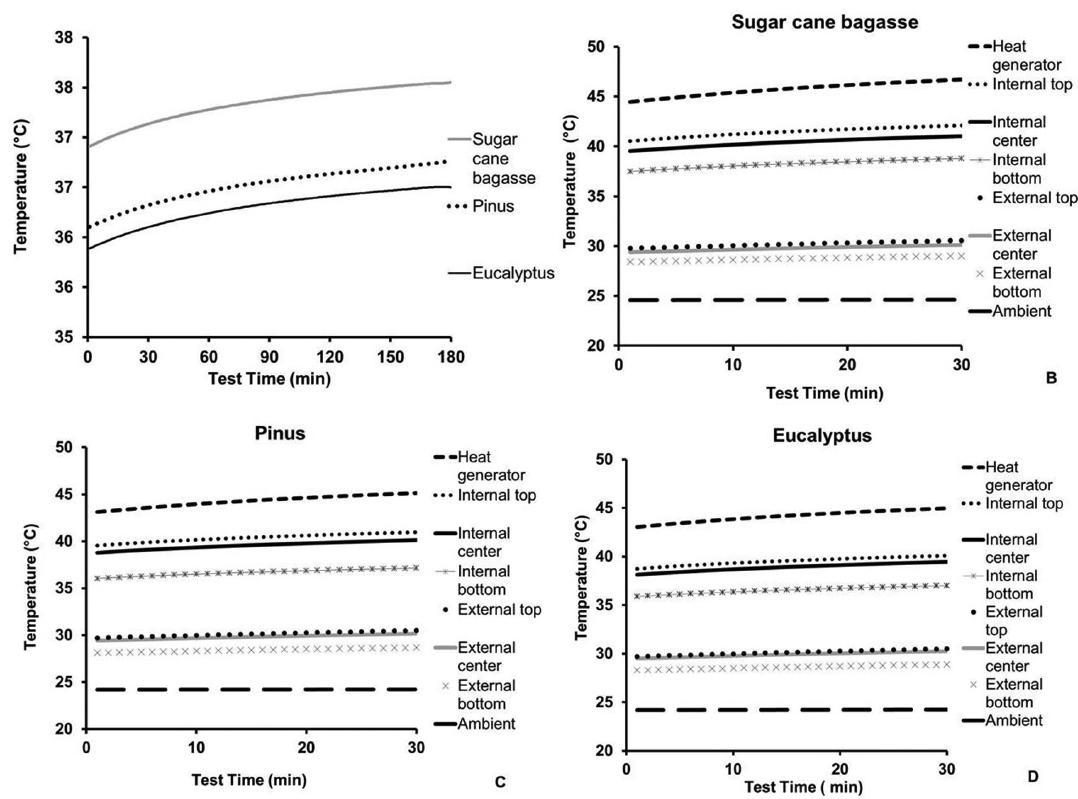
Figure 2. (A) behavior of the temperature throughout the test time for the three types of panel, behavior of the temperature in the first 30 minutes for the panel made of (B) sugar cane bagasse,(C) Pinus and (D)